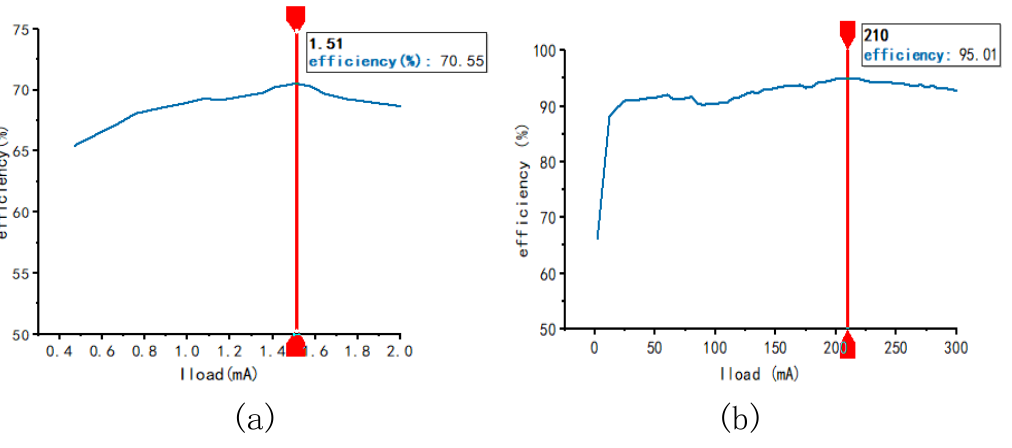
Figure 17. Experimental results of the efficiency of the proposed boost converter. ( a ) When the VIN = 0.7 V and ILOAD ∈ [0 mA, 2 mA]. ( b ) When the VIN = 3.6 V and ILOAD ∈ [0 mA, 300 mA].